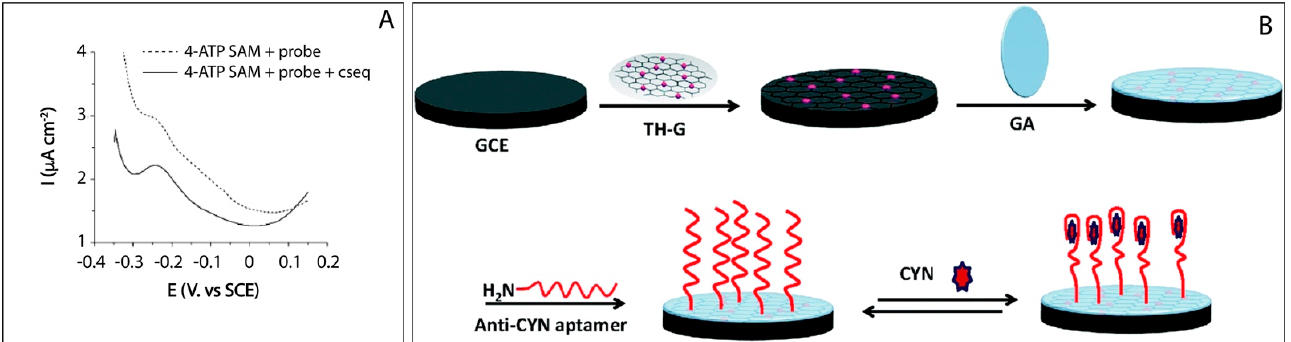
Figure 5. ( A ) Square-wave voltammograms of 4-ATP SAM modified electrodes after probe covalent attachment and hybridization with a complementary sequence, after MB accumulation. Reprinted with permission from Ref. [68]. Copyright 2008, Wiley; ( B ) Schematic representation of the label-free impedimetric aptasensor for cylindrospermopsin detection. Reprinted with permission from Ref. [69]. Copyright 2015, Royal Society of Chemistry.